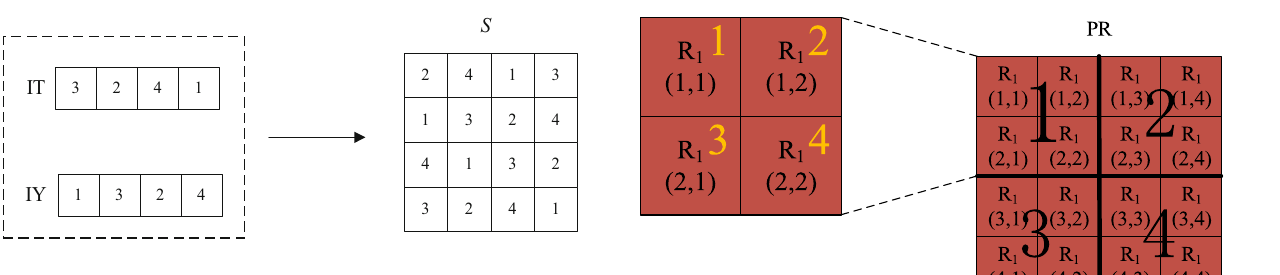
Fig. 3 Illustration of generating matrix S